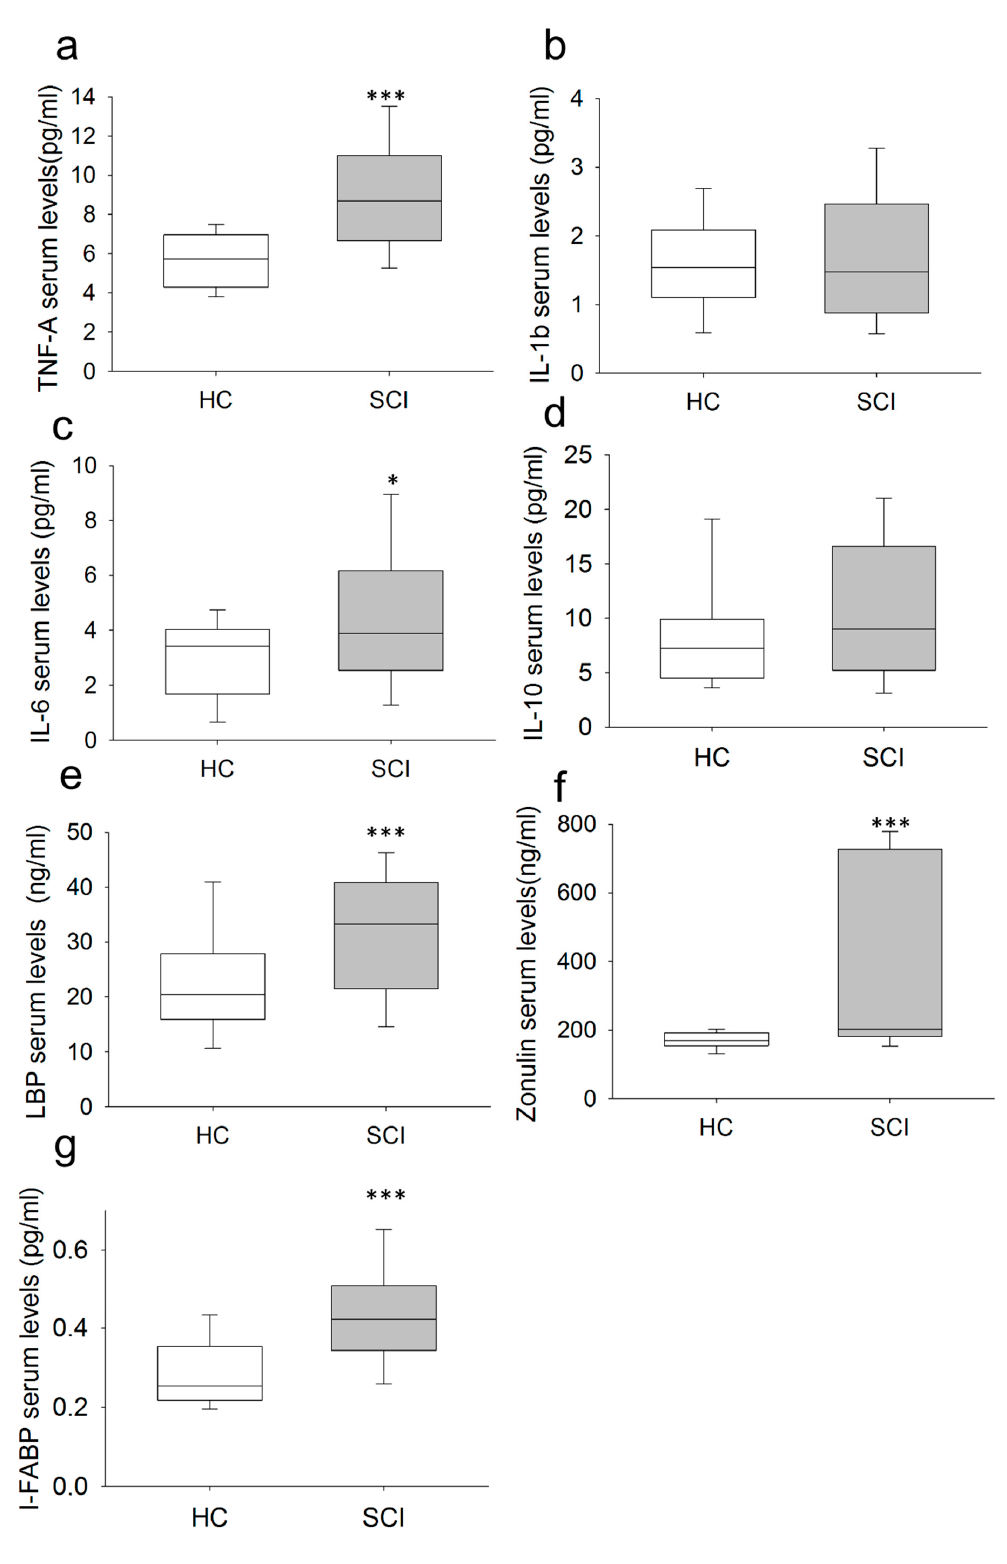
Figure 4. Determination of serum soluble mediators in chronic SCI patients. Serum concentrations of TNF- α : (panel ( a )) IL-1 β ; ( b ) IL-6; ( c ) IL-10; ( d ) LBP; ( e ) zonulin; ( f ) and I-FABP; ( g ) in chronic SCI patients (gray box) and healthy controls (white box) are shown. * Significant difference between patients and healthy controls ( p < 0.05). *** Significant difference between patients and healthy controls ( p <